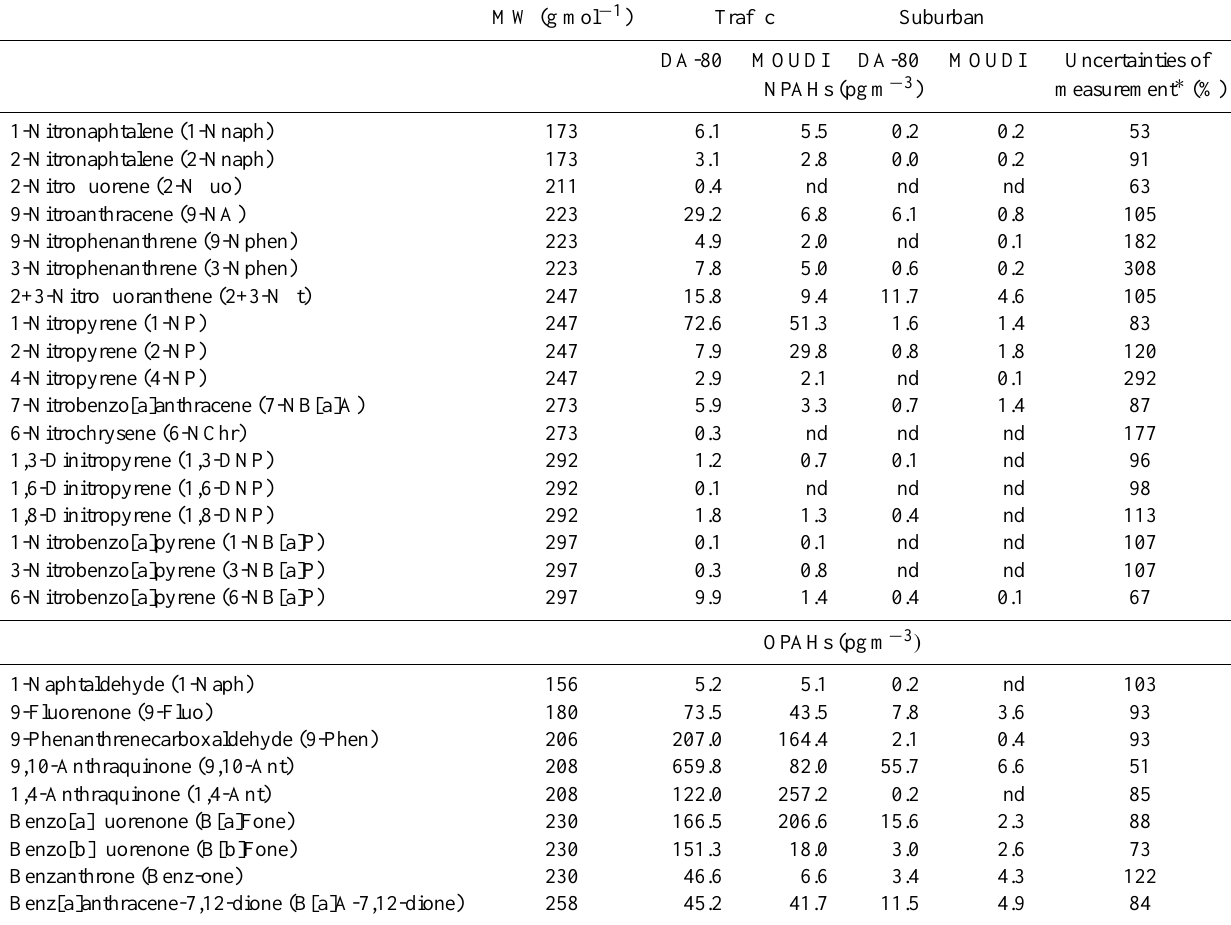
Table 1. Comparison of the atmospheric particulate NPAH and OPAH concentrations determined with both types of